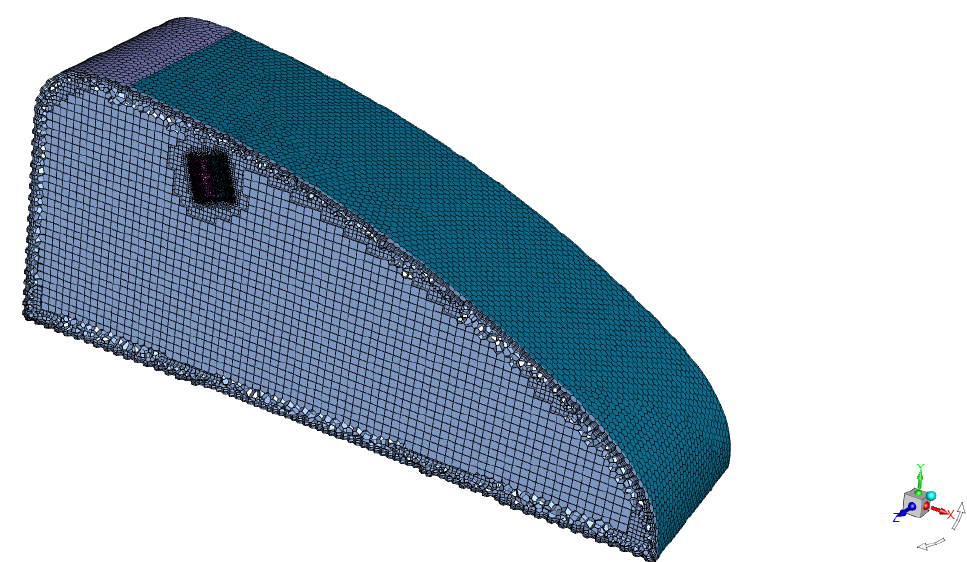
Figure 4. Computational grids used for the CFD simulation.